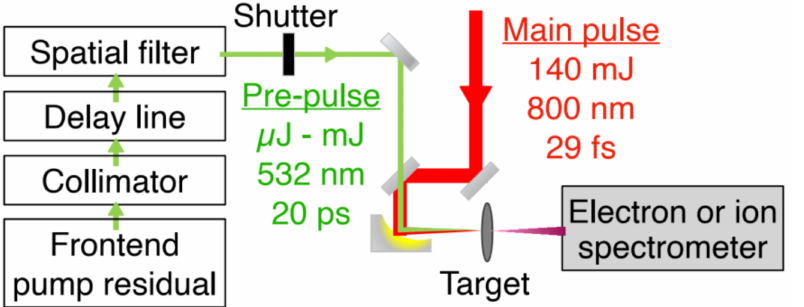
Figure 2. Schematic illustration of the irradiation setup. The main pulse (red) is focused using an off-axis parabolic mirror. The pre-pulse (green) is injected collinearly with the main pulse. Either a magnetic spectrometer or a Thomson parabola ion spectrometer is placed downstream to the generated